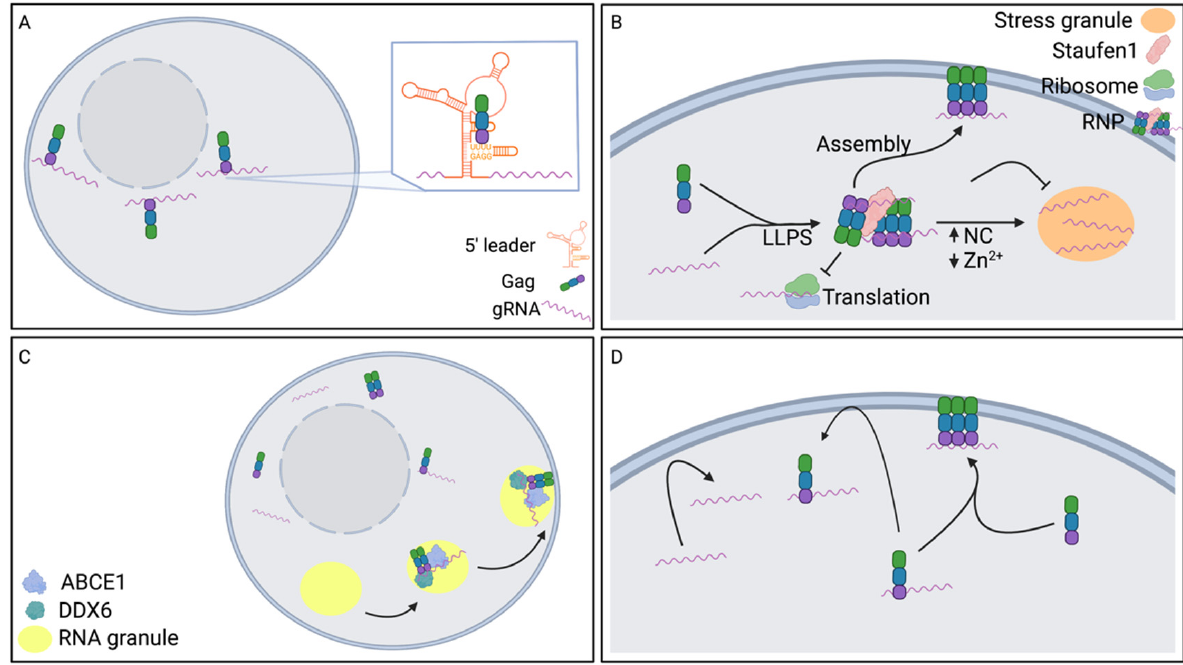
Figure 2. HIV-1 gRNA interaction with Gag and translocation to assembly sites. ( A ). Genome recognition occurs in the perinuclear region of the cell. ( B ). Phase separation of gRNA regulates translocation to virus particle assembly sites. Liquid-liquid phase separation (LLPS), Ribonucleoprotein complex (RNP), Gag nucleocapsid domain (NC). ( C ). Localization of gRNA to assembly intermediates promotes virus particle assembly. DEAD box Helicase 6 (DDX6), ATP Binding Cassette Subfamily E Member 1 (ABCE1) ( D ). Retention of gRNA at the plasma membrane is dependent upon interaction with Gag. Created with BioRender.com (accessed 4 May